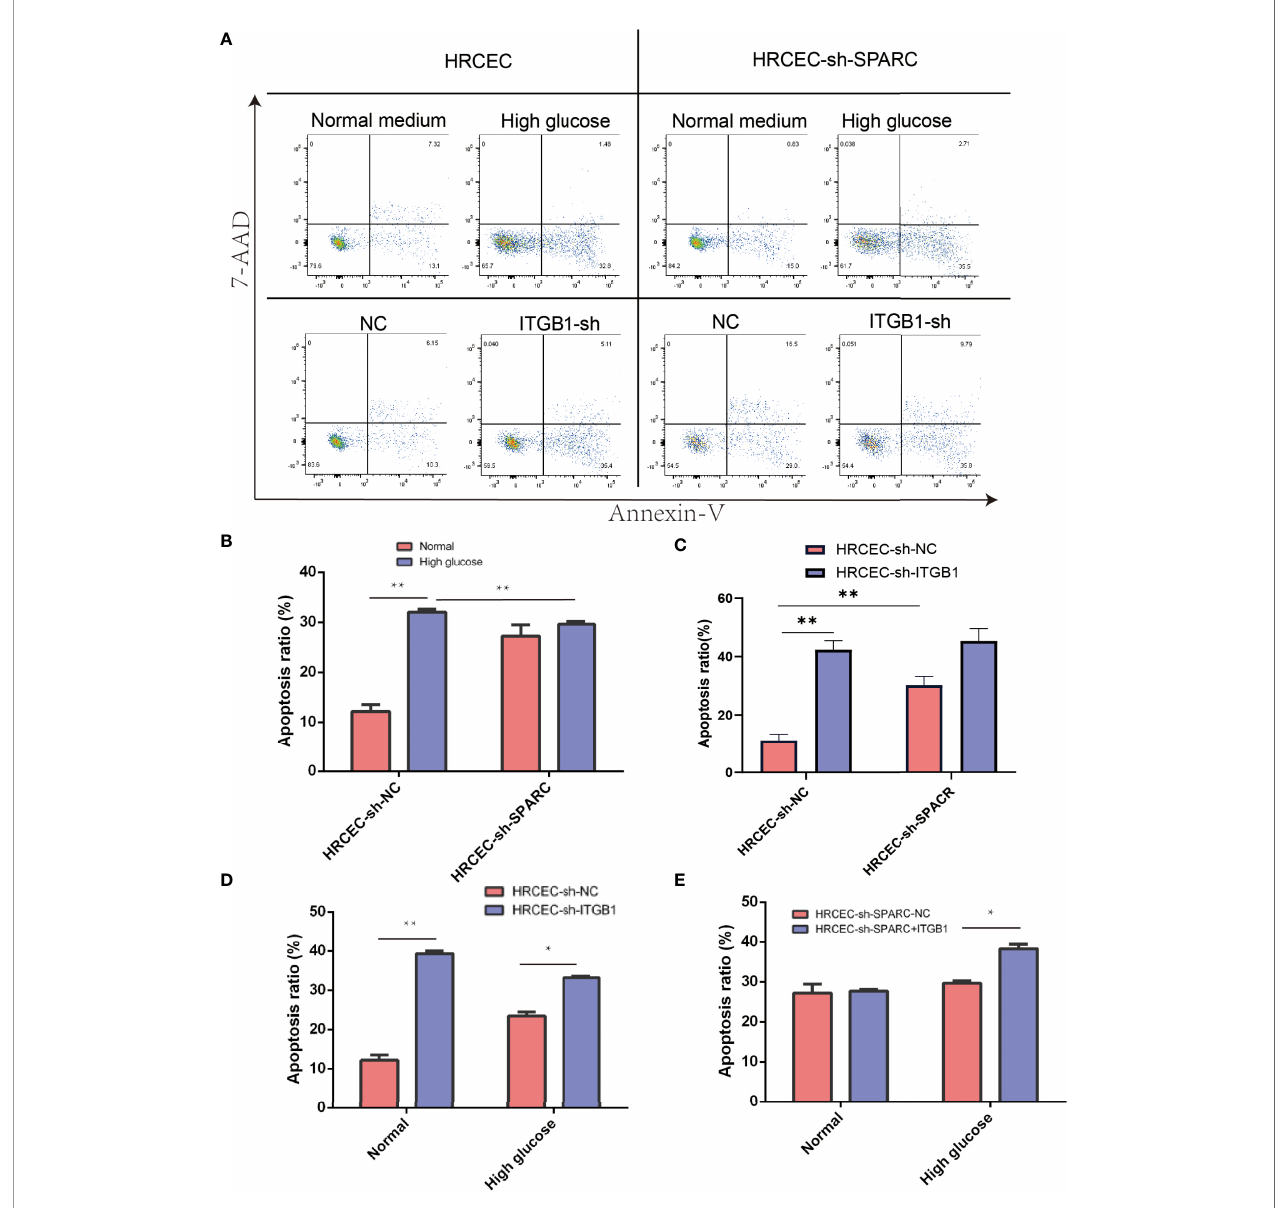
FIGURE 7 | Apoptosis level in ablation of SPARC and ITBG1 in different glucose-induced experiments. (A) Representative fi gure of fl ow cytometry. Annexin V/7- AAD assay was performed to determine the percentage of apoptotic cells. (B – E) Apoptosis ratio in ablation of SPARC and ITBG1 in different glucose-induced experiments. *: p < 0.05, **: p <